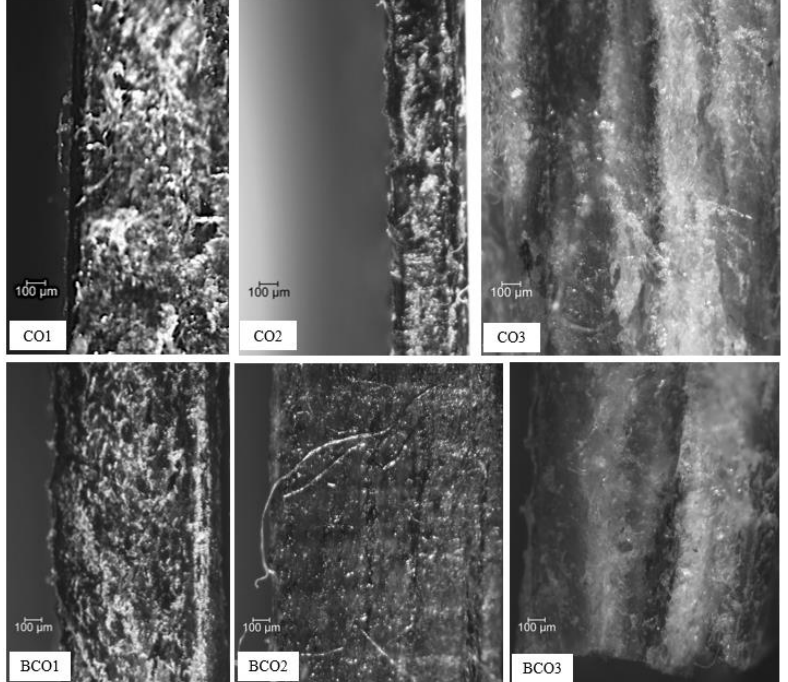
Figure 7. Microscopic comparison (×4) between cotton with partial dissolution (CO1); two-step method (CO2); two-step method with Dimethyl Sulfoxide (CO3; and blend cotton with partial dis- solution (BCO1); two-step method (BCO2) and two-step method with Dimethyl Sulfoxide